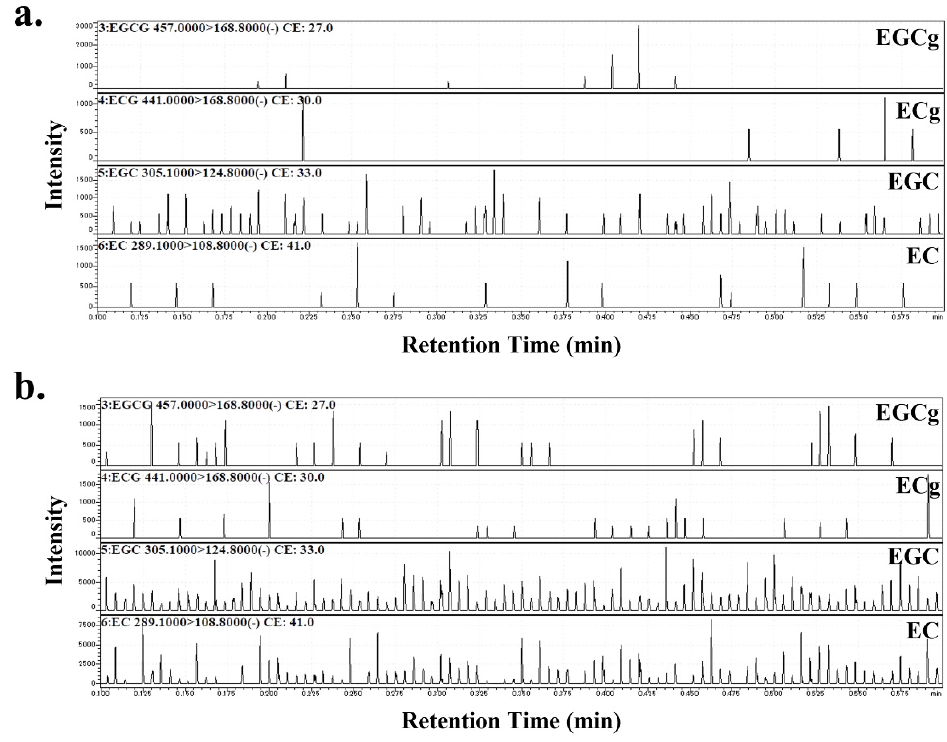
Figure 1. MRM chromatograms of ( a ) persimmon juice (PJ) and ( b ) persimmon leaves (PLs). The product ion (Pl) spectra of the compounds were measured in the multiple reaction monitor- ing (MRM)-Pl scan mode. The collision energies were adjusted to optimize the product ion signal as − 27, − 30, − 33, − 41 eV for ( − ) epigallo-catechin-3-gallate (EGCg), ( − ) epicatechin-3-gallate (ECg), ( − ) epigallocatechin (EGC), and ( − ) epicatechin (EC). The MRM mode was used to monitor the tran- sition of the deprotonated molecule at m/z 457.0 → 168.8 (EGCg), 441.0 → 168.8 (ECg), 305.1 → 124.8 (EGC), 289.1 → 108.8